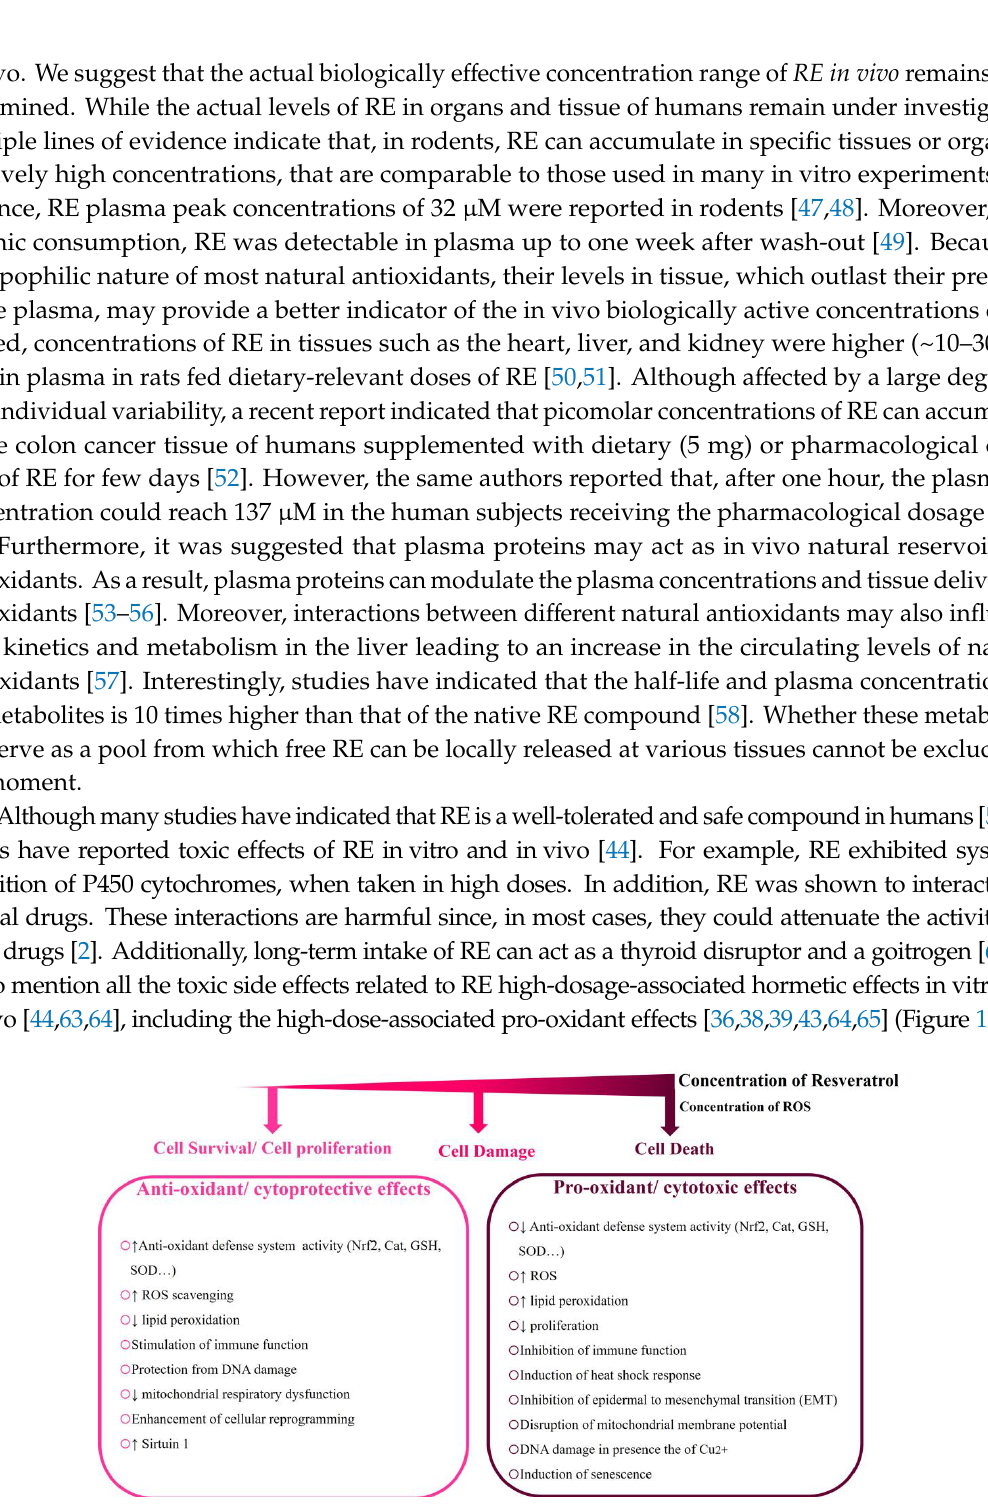
Figure 1. Biphasic hormetic dose-dependent e ff ects of resveratrol (RE). Resveratrol exhibits biphasic dose-dependent e ff ects. At low concentrations, RE acts as an antioxidant which can protect from DNA damage and oxidative stress. On the other hand, at high concentrations, RE acts as a pro-oxidant promoting DNA damage while increasing oxidative stress. Low and high concentrations o ff er beneficial e ff ects in the prevention of cancer formation (chemo-preventive) and in the treatment of cancer (cytotoxic),